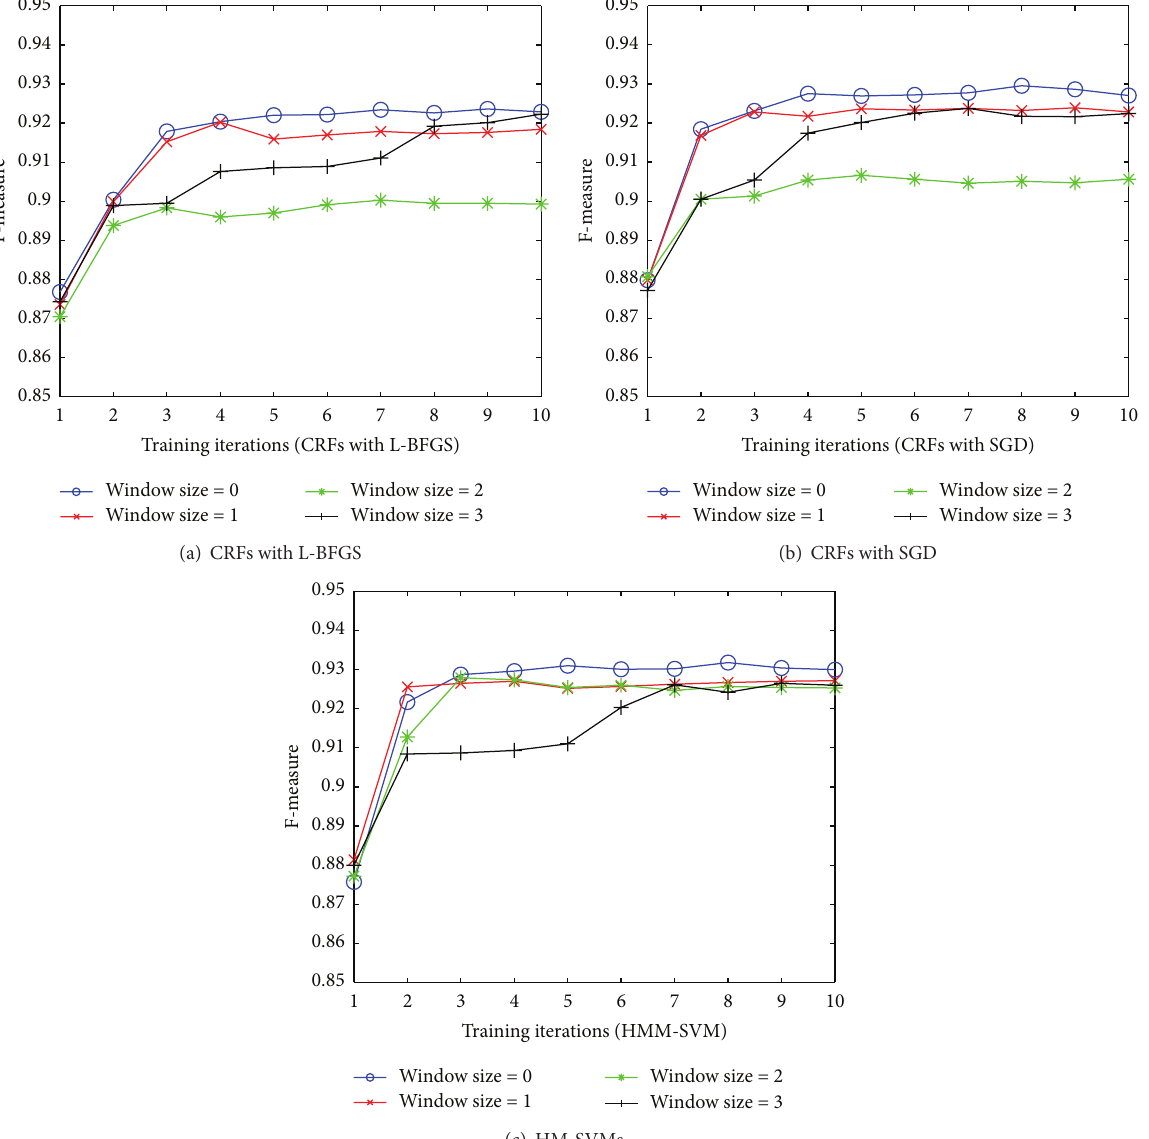
Figure 4: Comparison of performance on models learned with feature sets chosen based on different window